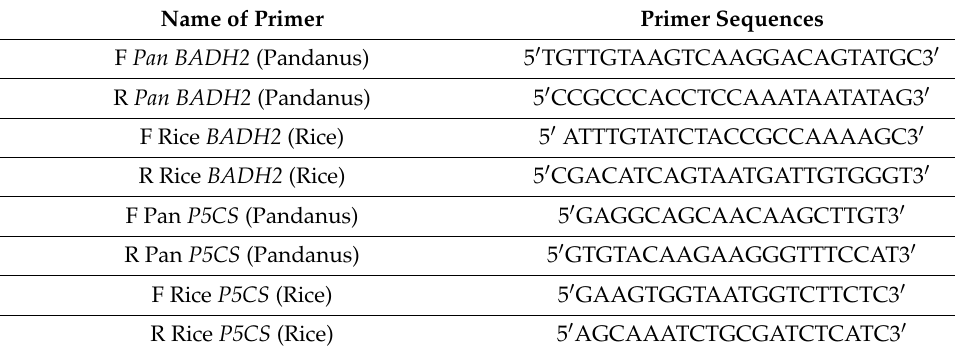
Table 1. Primers used for PaBADH2 real-time expression analysis. Name of